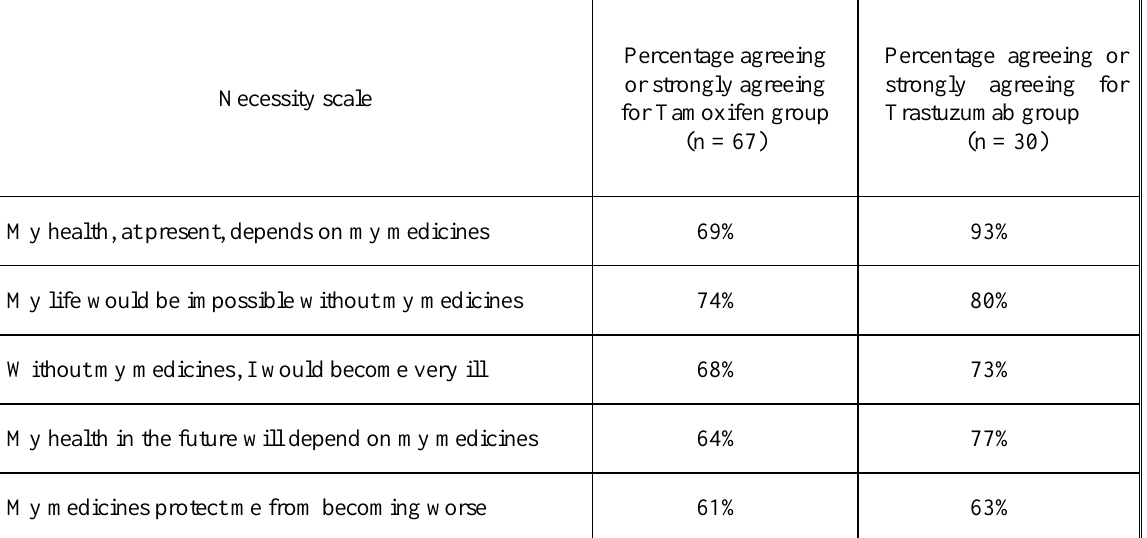
Table 4. Percentages of Tamoxifen and Trastuzumab users agreeing /strongly agreeing with Beliefs about Medicines Questionnaire -Necessity statements .